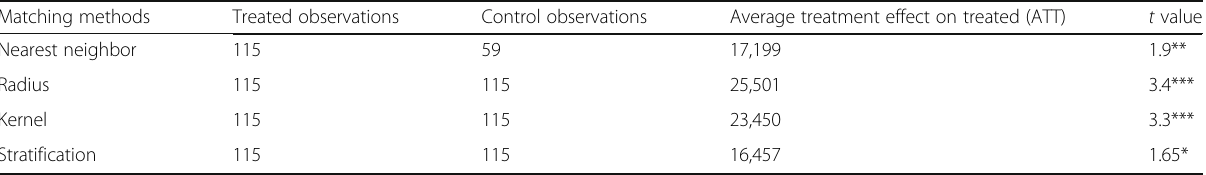
Table 9 Impacts of SLM practices on the crop production at household level Matching